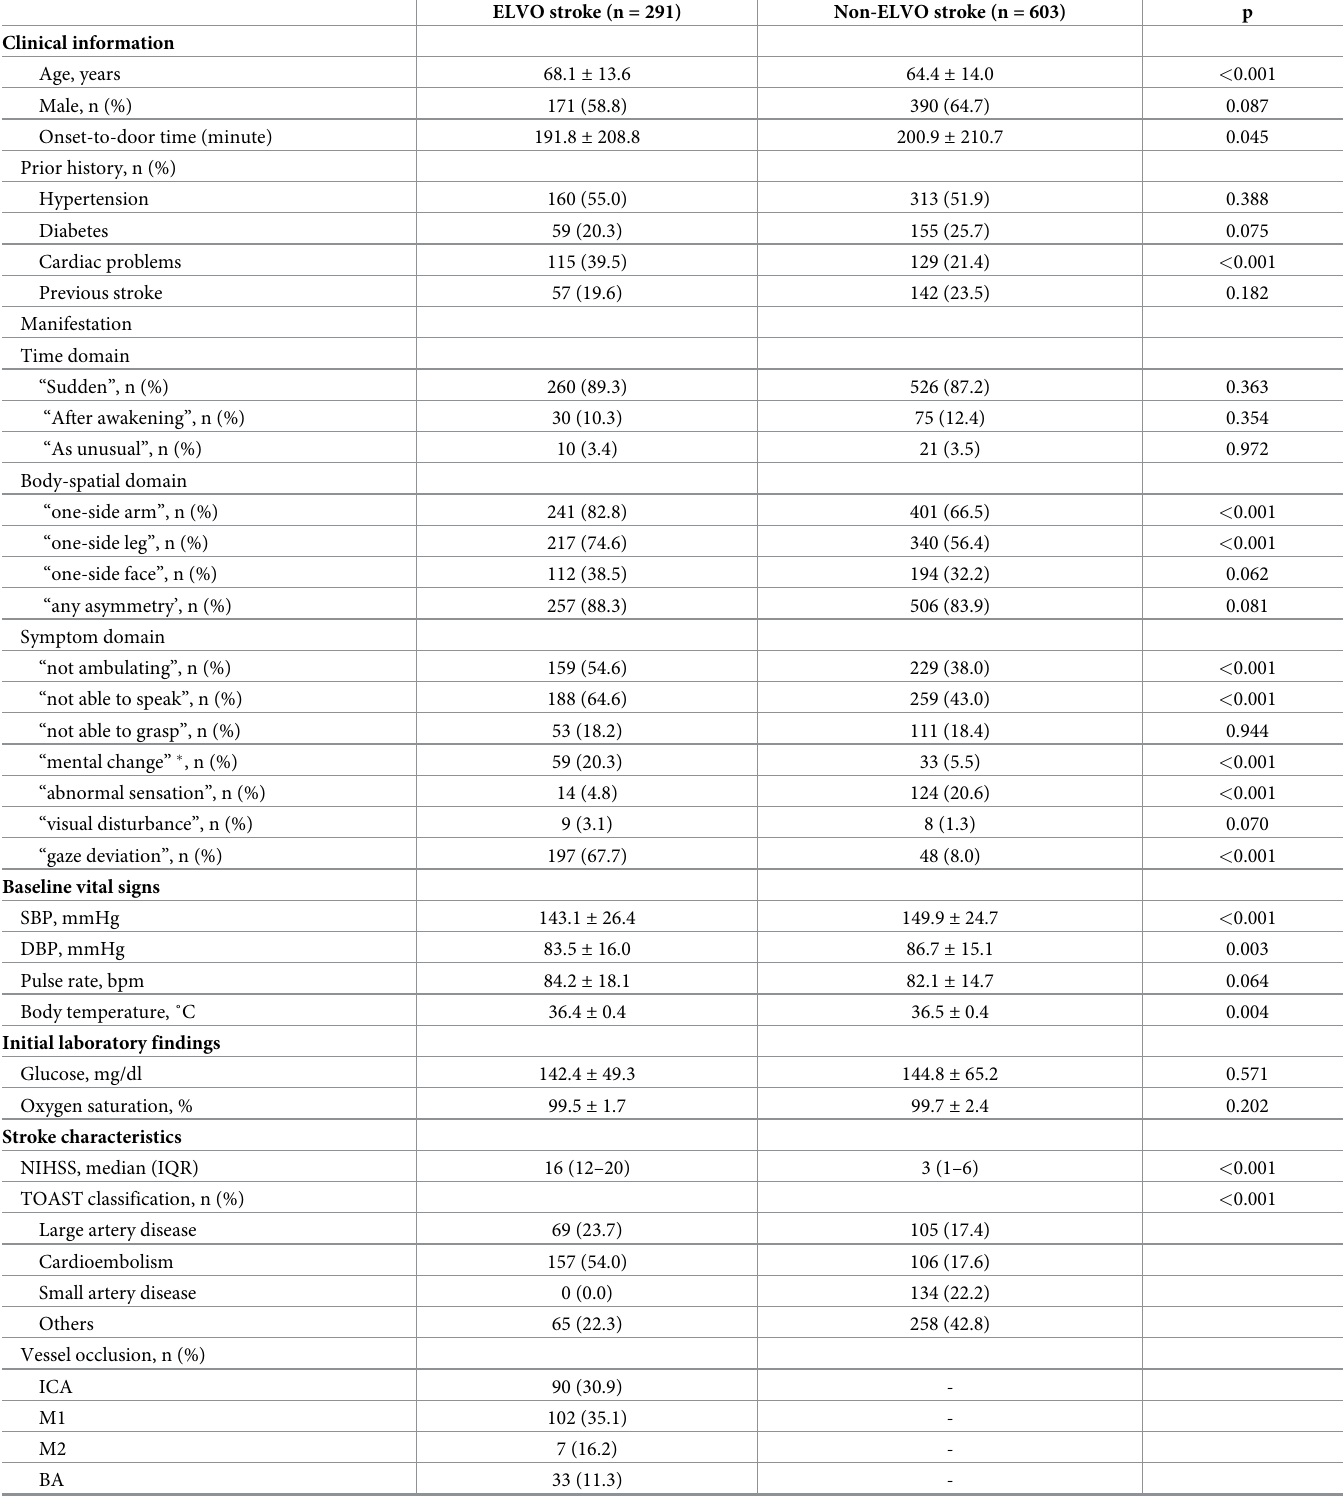
Table 2. Clinical information, vital signs, and initial labs (CIVIL) between ELVO and non-ELVO